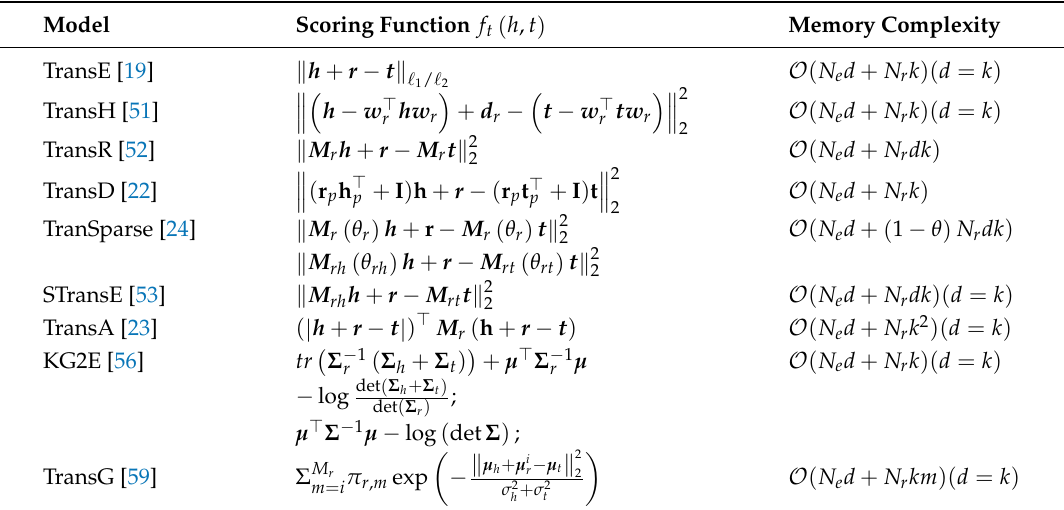
Table 2. Comparison of translation-based models in terms of scoring functions and memory